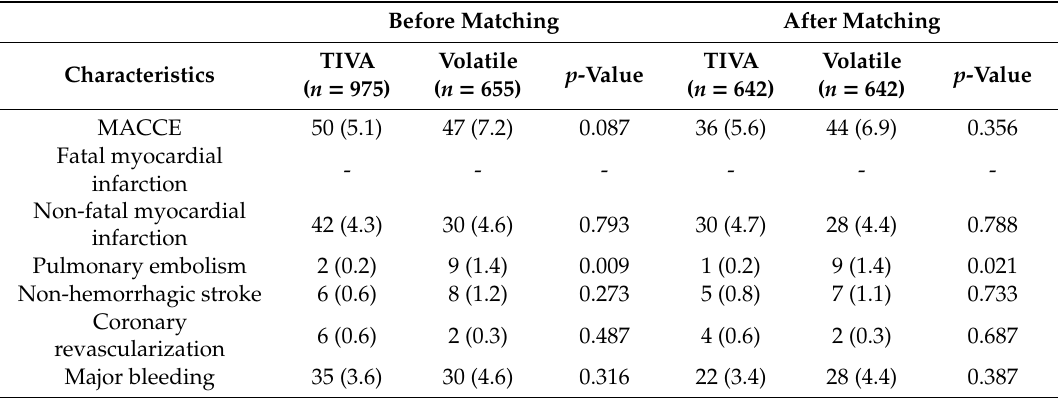
Table 3. Comparisons of major adverse cardiovascular and cerebral event and major bleeding between patients with total intravenous anesthesia and volatile anesthetics before and after propensity score matching.